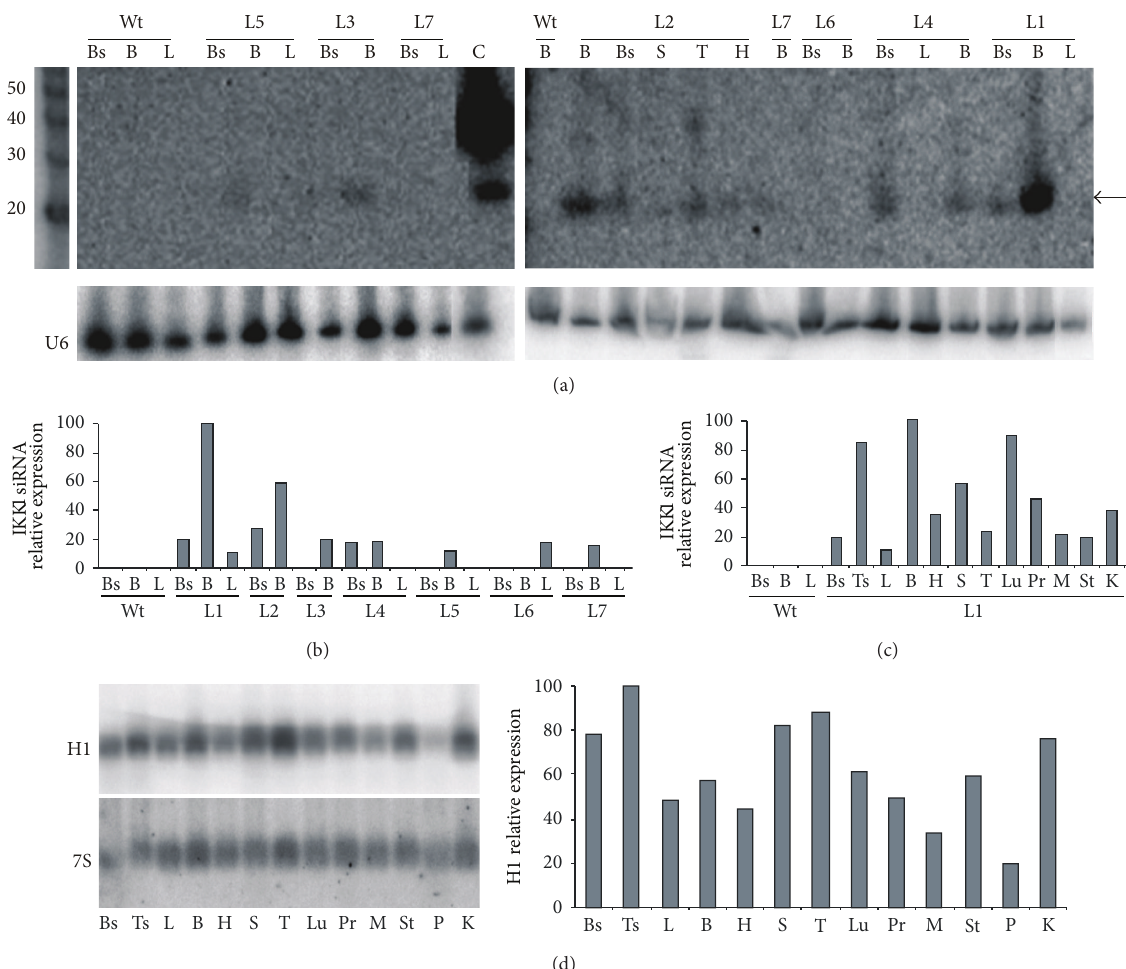
Figure 3: Expression of IKK1 siRNA in transgenic mice. (a) Upper part: representative examples of the northern blots performed for analysis ofIKK1siRNAexpressioninorgansfromH1-IKK 𝛼 -siRNAtransgeniclines.LaneCisapositivecontrolthatcontainsRNAfromthetransfected cells loaded in the first lane of Figure 1(b). The black arrow indicates the position of the specific 21-nucleotide band. Samples from wild-type animals gave no signals for IKK1 siRNA. The motilities of 20-, 30-, 40-, and 50-nucleotide RNA fragments are indicated. Lower part: the same blots were hybridized with a probe specific for U6 RNA, as a loading control. (b) Relative expression levels of IKK1 siRNA in different transgeniclines;siRNAintensitieswerenormalizedagainsttheircorrespondingU6signalsandpresentedasapercentageofthevalueobtained for brain in line L1. (c) Relative expression level of IKK1 siRNA in organs of L1 transgenic mice. Signals obtained with an U6 probe were used for normalization. (d) H1 expression in control mice. The same blot was hybridized with a 7S-specific probe, as a loading control. In the histogram of the right, the relative expression of H1 normalized against 7S signals in different organs of control mice is shown. B: brain;